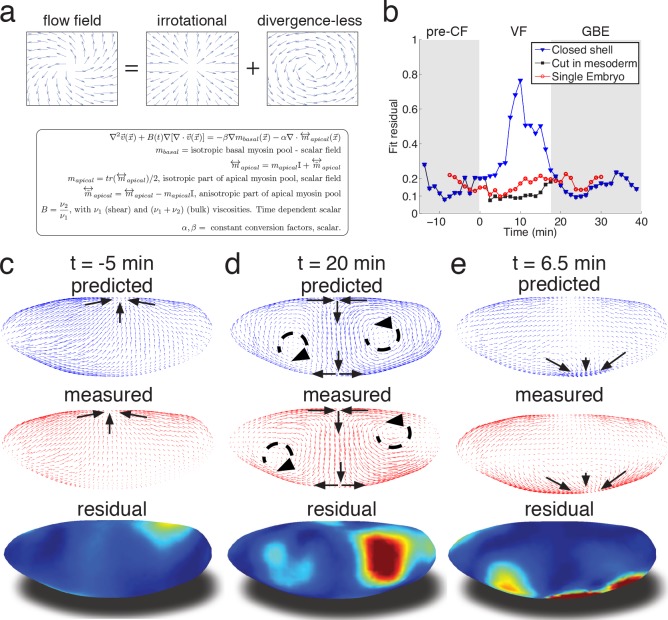
Biophysical model quantitatively predicts tissue flow based on quantitative measurements of myosin distribution.(a) Proposed mathematical description of the flow parameterizes complex mechanics of cytoskeleton in terms of the shear ν1 and ν2 bulk effective viscosities. The flow is driven by the force proportional to the divergence of the myosin tensor (see SI) on the right-hand-side of Equation 3a. Because effective viscosity tends to suppress velocity differences of neighboring cells, the response to local forcing is felt globally, e.g. effect of a local myosin perturbation results in local as well as non-local changes of the flow field. (b) Fit residual, comparing predicted flow field with measured flow field (see SI Finite Element implementation for a detailed definition of the residual) as a function of time. Both fields are normalized for average magnitude. The average magnitude of predicted velocity field defines one of our fitting parameters. Images of the single embryo are shown in Figure 1—figure supplements 2–3 (c–e) Representative time points of morphogenetic flow: pre-CF (c), GBE (d) and VF (e). From top to bottom: spatial distribution of predicted (blue), measured (red) flow field, and residual (blue best agreement, red worst, on a scale from 0 to 1). For the case of VF flow, predictive model is modified to allow for a ‘cut’ in ventral region (see SI text, and Figure 3—figure supplement 1 for detail).